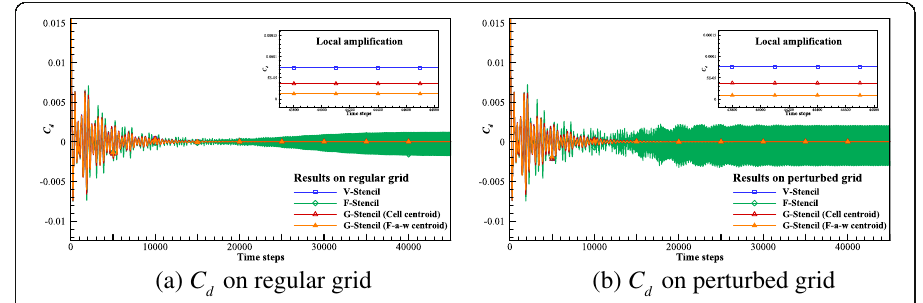
Fig. 30 C d on ( a ) regular and ( b ) perturbed triangular